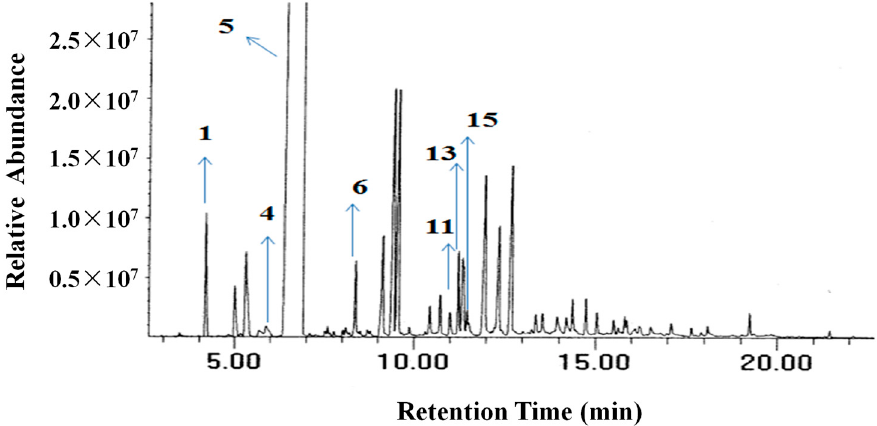
Figure 1. Total ion chromatogram of navel orange essential oil (NOEO).